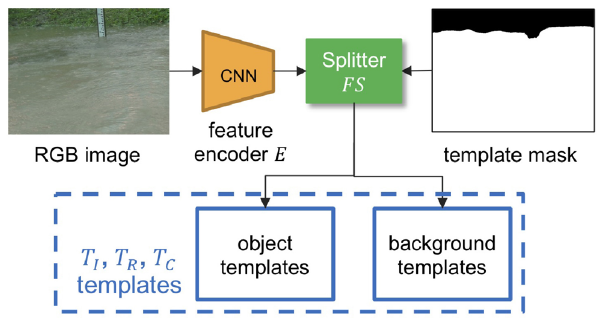
Fig. 4 Pipeline of feature splitter FS . Feature encoder E takes the input RGB image to produce a feature map. The splitter is a deterministic module that divides the feature map into object feature templates and background feature templates according to the segmentation